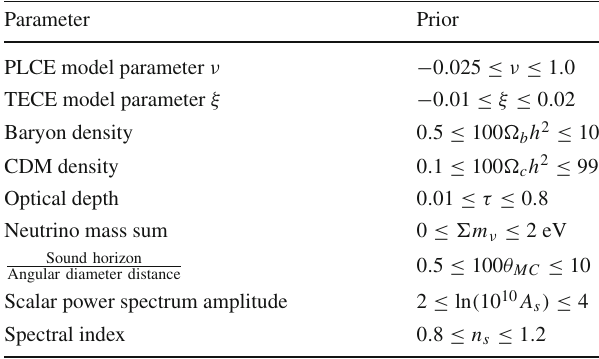
Table 2 Priors for cosmological parameters in the PLCE and TECE models